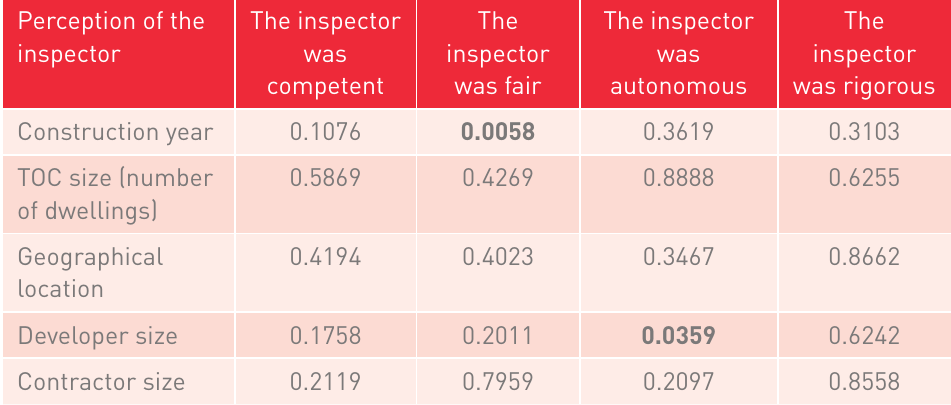
Perception of the inspector, p-values, Kruskal-Wallis test with